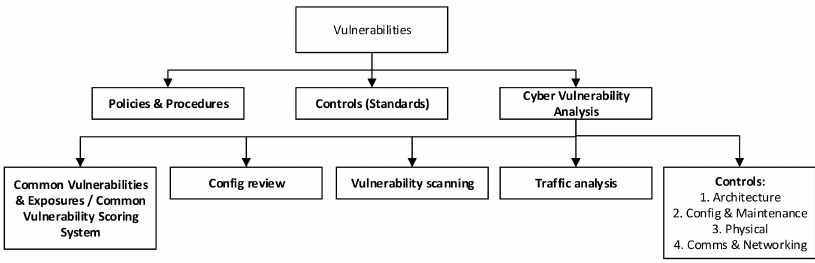
Figure 8. Vulnerability taxonomy [19].